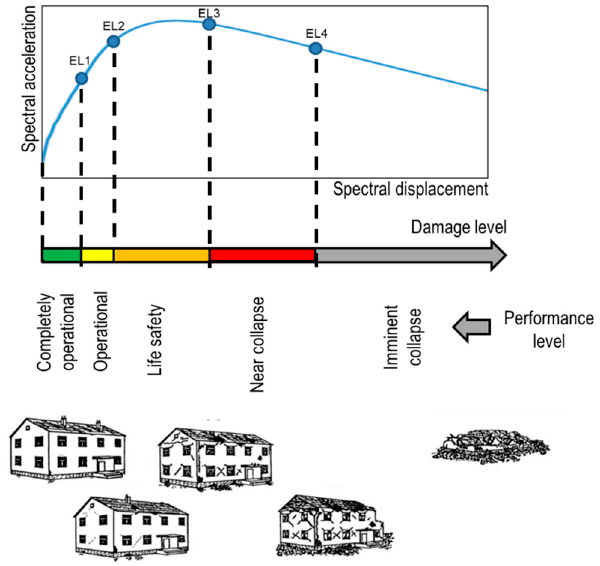
Figure 7. Illustrative capacity curve in the acceleration–displacement (Sa–Sd) format and identifi- cation of damage and performance levels, as well as response limit states. Table 3. Definition of seismic response limit states.